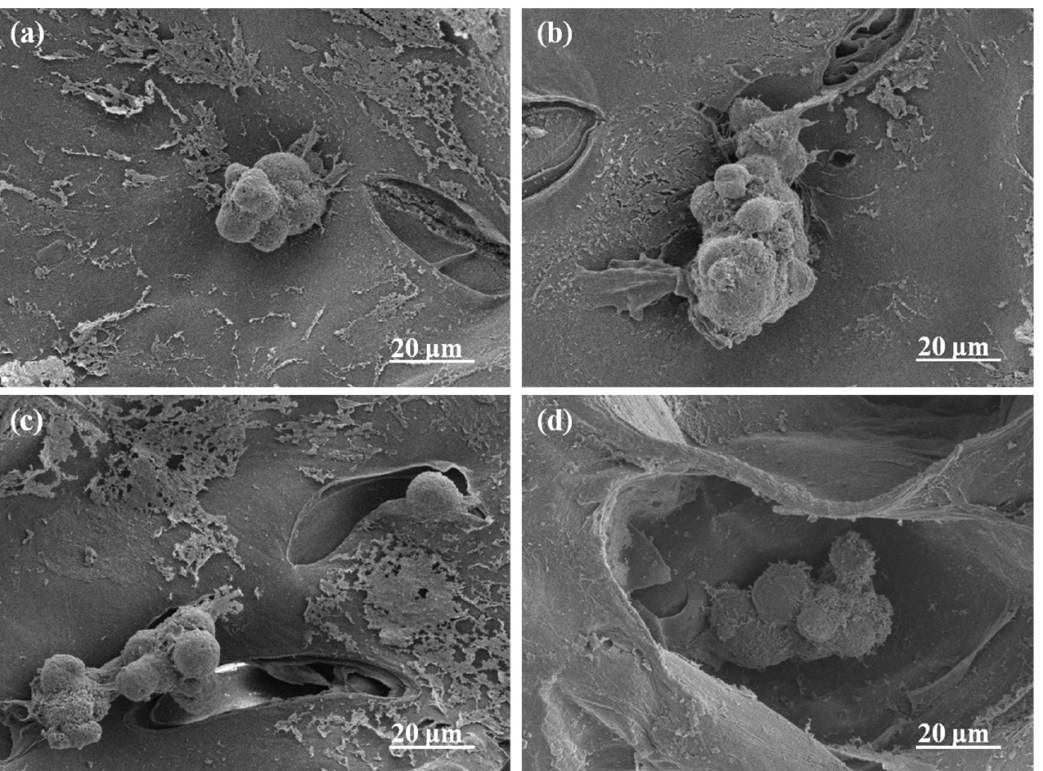
Figure 7. SEM images of MC3T3-E1 cells cultured on the composite hydrogels for 2 d: ( a ) Alg Gel, ( b ) Alg-GT, ( c ) Alg-CS-GT and ( d ) Alg/GT-CS.